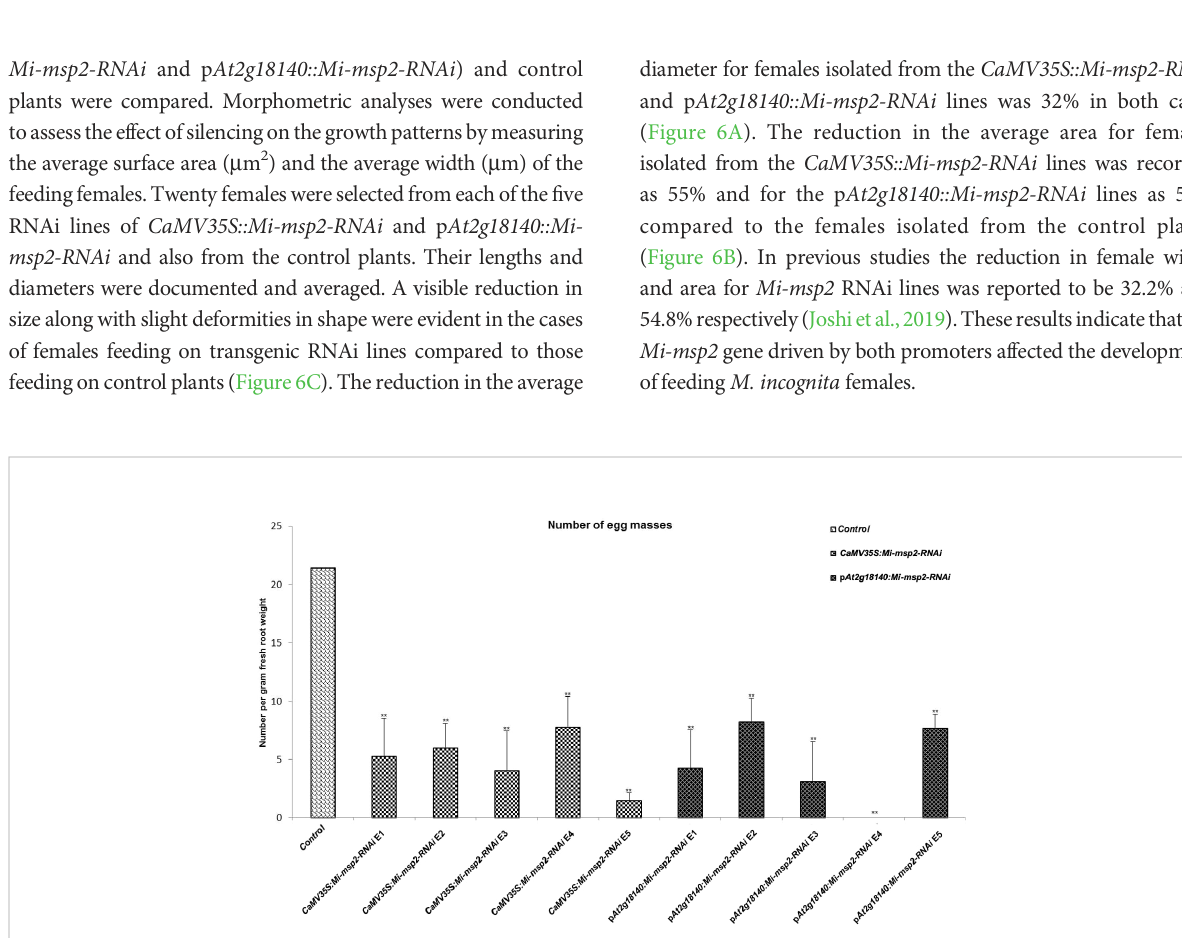
FIGURE 3 Five independent RNAi lines each for constructs CaMV35S:Mi-msp2 and p At2g18140::Mi-msp2-RNAi exhibit a reduction in infection represented by a reduction in the number of females isolated from infected roots compared to the control line evaluated for M. incognita infection. Each bar represents the mean ± SE. Double asterisks indicate statistically signi fi cant differences by one-way ANOVA and Tukey ’ s test (p ≤ 0.01).